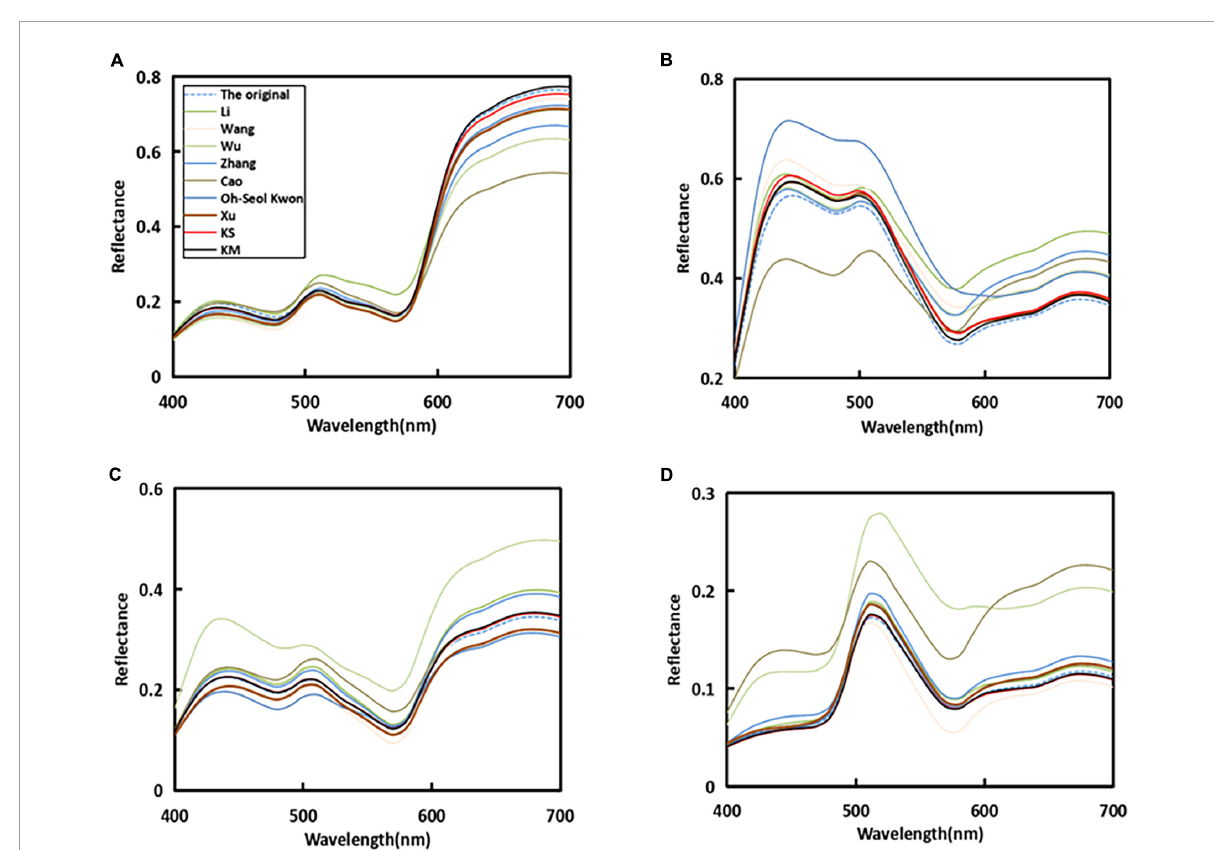
FIGURE9 Reflectance recovery results from our proposed and existing methods with four randomly selected samples in a real